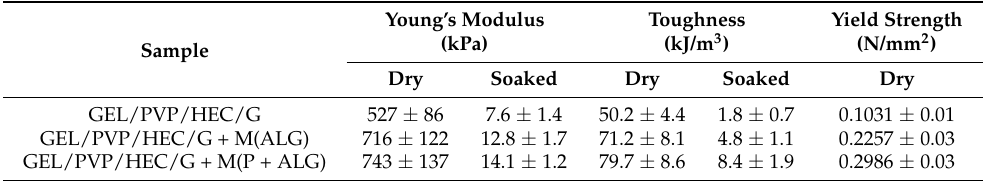
Table 3. The values of Young’s modulus, toughness, and yield strength of the prepared materials under different conditions—dried and after submerged in PBS solution (values with standard